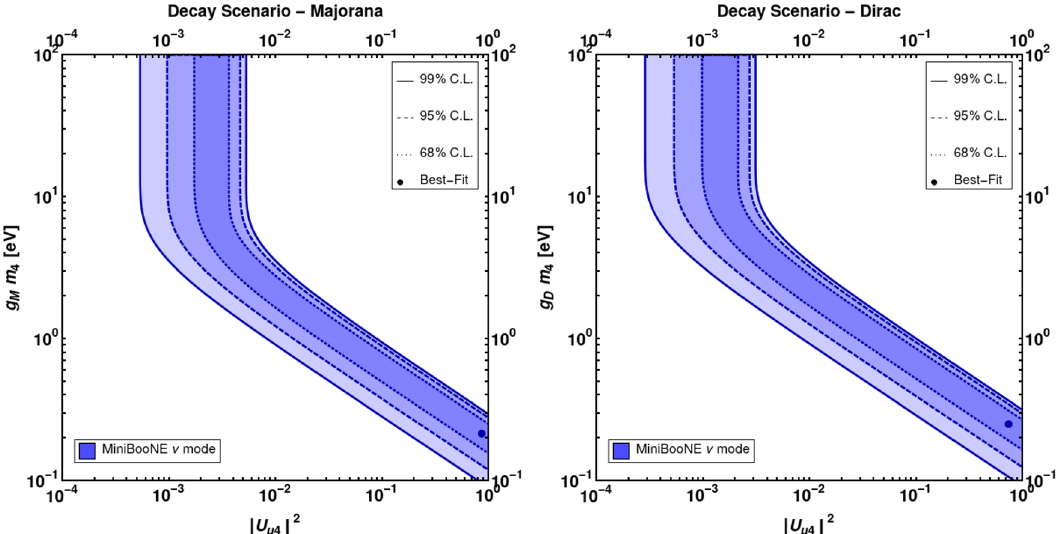
Figure 4 . Allowed regions of the ( j U (cid:22) 4 j 2 ; gm 4 ) parameter space when the decaying-sterile-neutrino hypothesis is matched against the MiniBooNE neutrino-mode data assuming Majorana (left) or Dirac neutrinos (right). The dots indicate the best-(cid:12)t-point and the lines represent the 99% (solid), 95% (dashed) and 68% (dotted) C.L. curves.